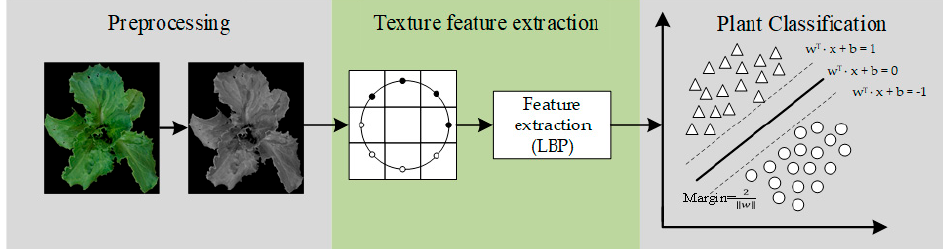
Figure 2. General scheme of the classification method based on support vector machine (SVM).